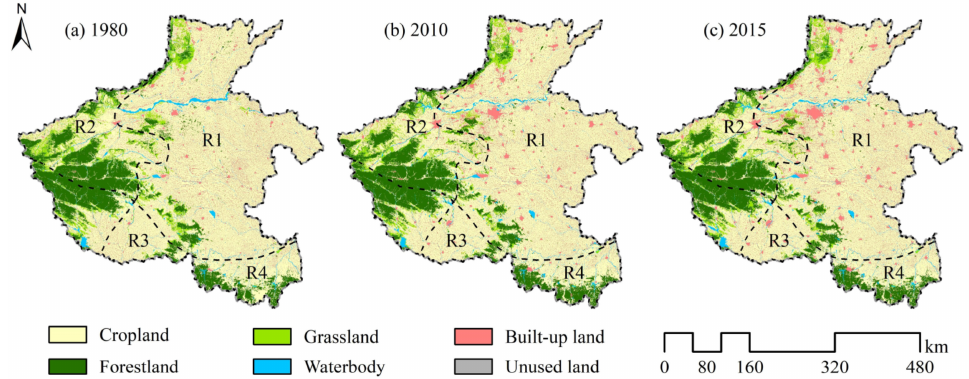
Figure 2. Spatial distribution of LUCC in Henan Province in 1980, 2010, and 2015.